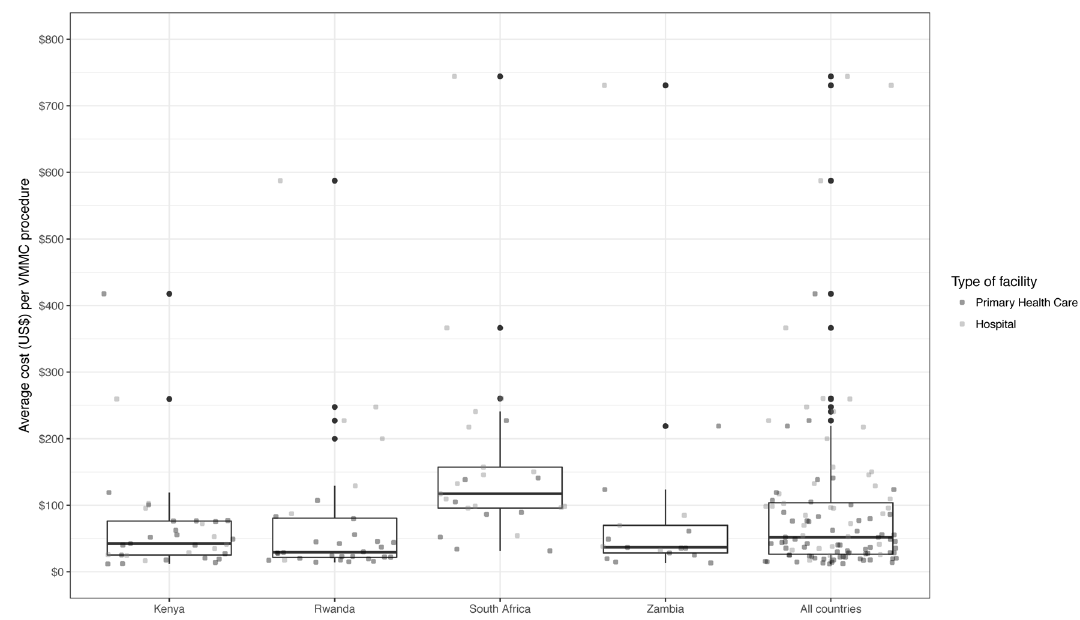
Fig 1. VMMC unit cost variation by type of facility and country. Lines inside the box indicate the median of the distribution; boxes depict the inter-quartile range (IQR); whiskers extend to 1.5 times the IQR; one observation was excluded from the plot ( >